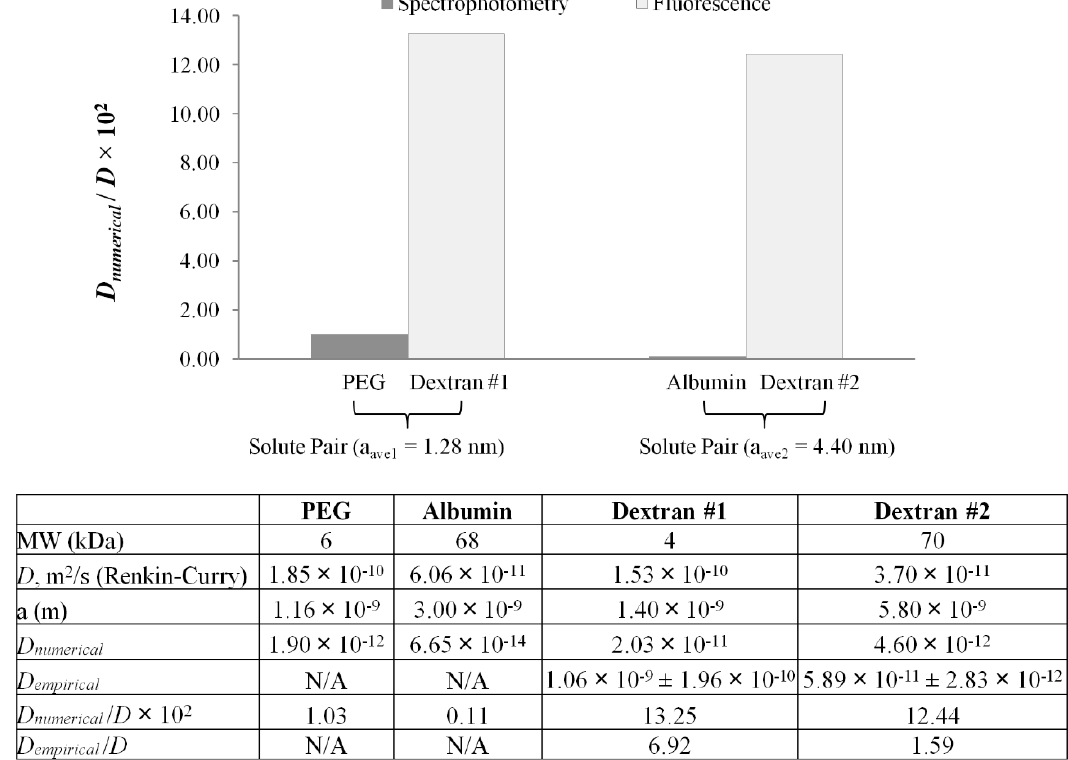
Figure 4. Comparison of numerical diffusivity ratios ( D numerical / D ) between spectrophotometry and 2D fluorescence. Average stokes radii for each solute pair are as follows: a ave1 = 1.28 nm for polyethylene glycol (PEG)/dextran #1, and a ave2 = 4.40 nm for albumin/dextran #2. Numerically-computed diffusivity ( D numerical ) for PEG and dextrans previously reported in